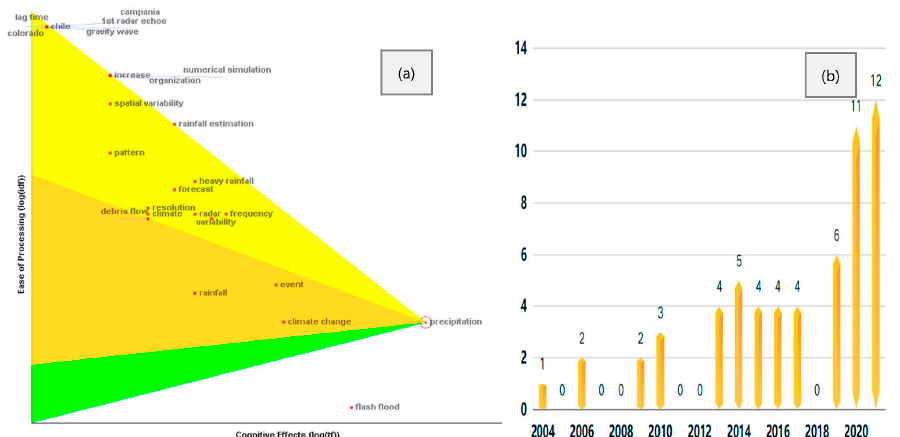
Figure 14. Details of the key node “precipitation”. ( a ) Pennant illustration; ( b ) publication timing outbreak.